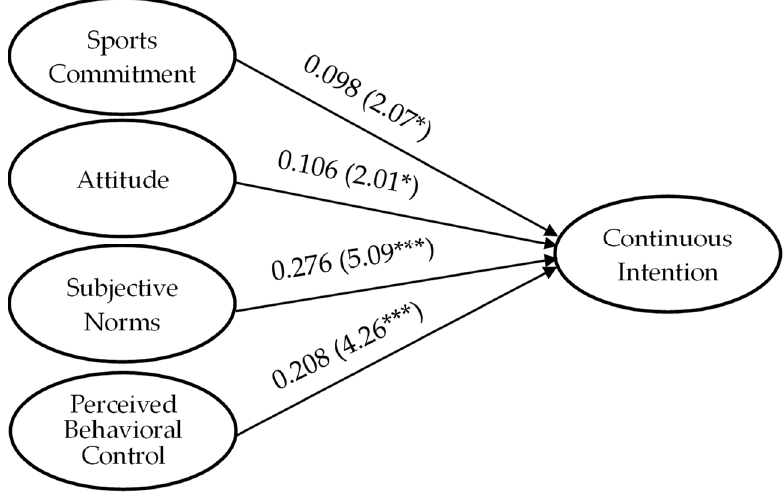
Figure 2. Model verification results for the continuous intention of older adult participants in virtual reality sports.